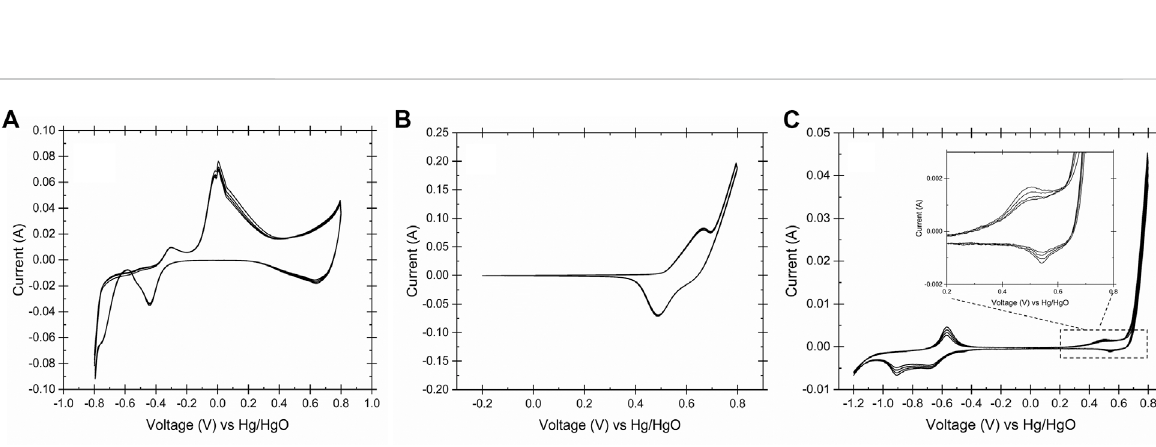
TABLE 1 Comparison of the performance of the different electrodes on E-WAS at 1.35 V, 35 ° C and 2 h operation time. Electrode